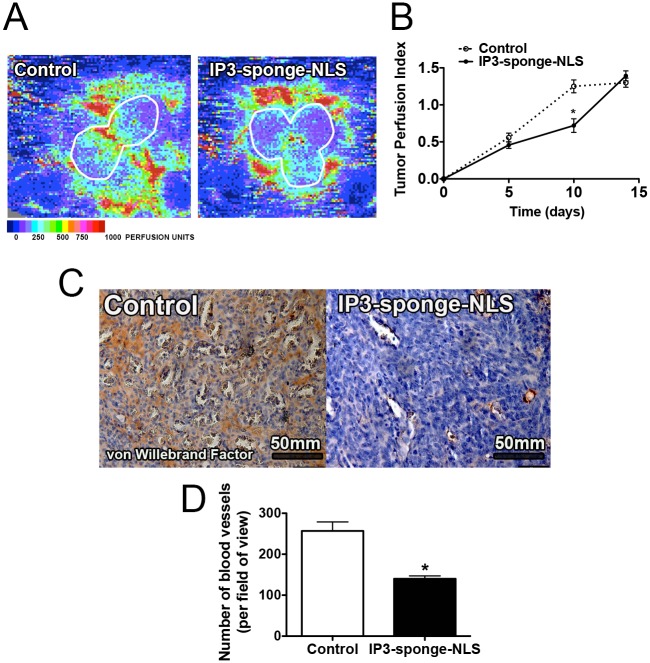
Nuclear IP3 buffering reduces TNBC angiogenesis.(A) Representative image of non-invasive Laser-Doppler 10 days after tumor induction. White lines indicate tumor region of interest. Tumor perfusion index is assembled from mean Doppler velocity and analyzed according to the color scale at the bottom. (B) Average tumor perfusion index 5, 10 and 15 days after tumor induction (n = 5, for each time point). (C) Representative image of von Willebrand factor immunostaining. Scale bar = 50mm. (D) Average number of blood vessels per field of view. Results are average values of 6 animals per group and 5 randomly selected fields of view per animal. * = p <0.05 versus control. Values are expressed as mean ± SD.